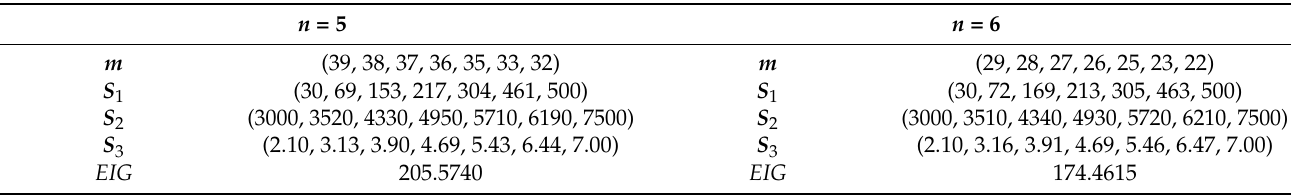
Table 7. The optimal test plan of pre-test optimization ( n = 5, n = 6).